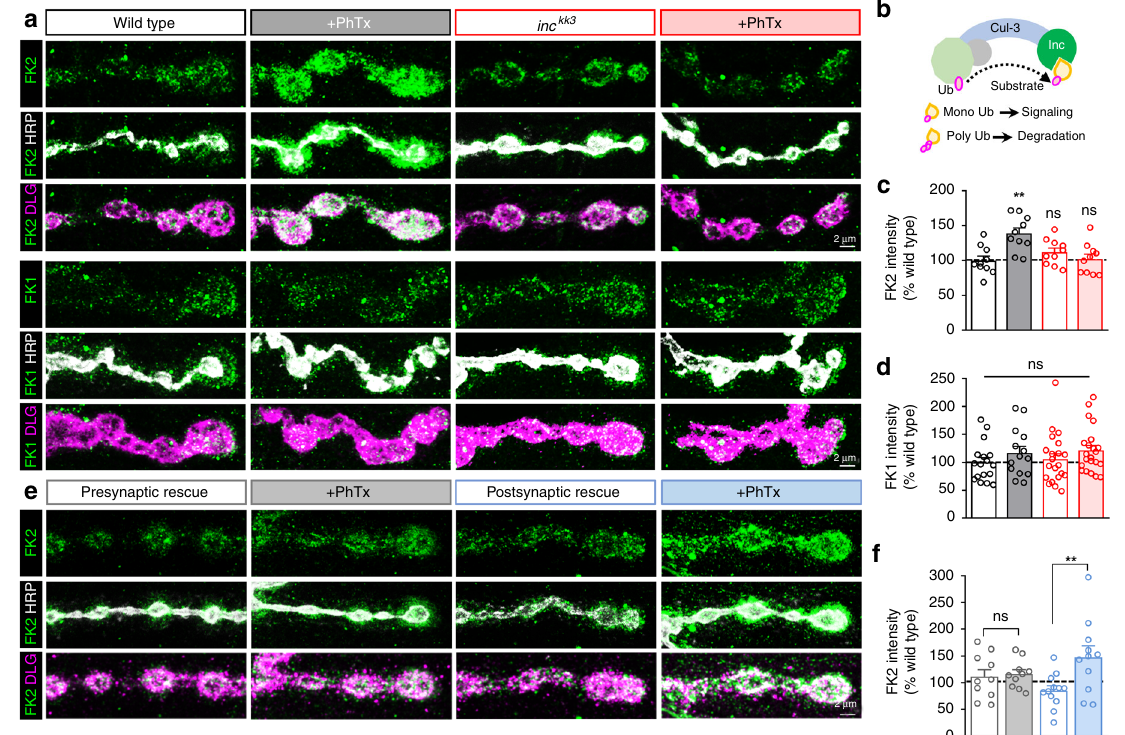
Fig. 5 inc is required for rapid mono-ubiquitination at postsynaptic compartments following glutamate receptor perturbation. a Representative NMJ images from wild-type and inc mutants immunostained with anti-FK2 (mono- and poly-ubiquitin) or anti-FK1 (poly-ubiquitin only), -HRP and -DLG, before and after PhTx application. At wild-type NMJs, the FK2 signal rapidly increases at postsynaptic densities after PhTx application (indicated by the signal outside of HRP), while no change is observed in the FK1 signal. However, no change in either FK2 or FK1 intensity is observed at baseline or after PhTx application in inc mutant NMJs. b Schematic illustrating the Cul3 ubiqutin ligase complex, where Inc serves as an adaptor to target substrates for either mono- ubiquitination (which can confer signaling functions) or poly-ubiquitination (which leads to proteasomal degradation). Quanti fi cation of average FK2 ( c ) and FK1 ( d ) immunointensity levels after PhTx application in the indicated genotypes normalized to wild type ( – PhTx: wild type, n = 10 (FK2), n = 17 (FK1); inc kk3 , n = 10 (FK2), n = 21 (FK1); + PhTx: wild type, n = 10 (FK2), n = 14 (FK1); inc kk3 , n = 10 (FK2), n = 22 (FK1)). e Representative NMJ images immunostained with anti-FK2, -HRP, and -DLG in inc mutants rescued presynaptically or postsynaptically at baseline and after PhTx application. While the FK2 signal fails to increase after PhTx in the presynaptic inc rescue condition, the FK2 signal increase is restored in the postsynaptic rescue. f Quanti fi cation of mean FK2 intensity in the indicated genotypes normalized to wild-type values ( – PhTx: presynaptic rescue, n = 10; postsynaptic rescue, n = 12; + PhTx: presynaptic rescue, n = 10; postsynaptic rescue, n = 11). Asterisks indicate statistical signi fi cance using a one-way ANOVA followed by Tukey ’ s